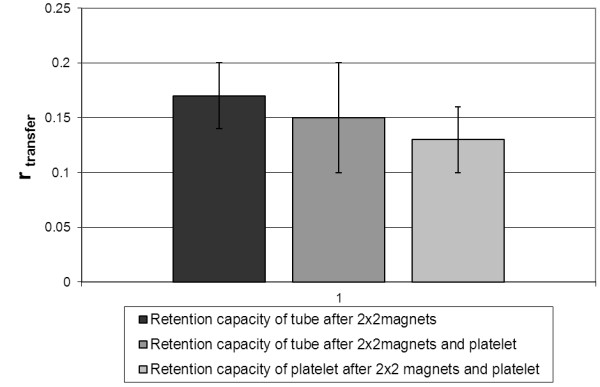
Flushing experiments simulating the in vivo situation. Retention capacity of the tube or platelet and tube, respectively, during flushing of the system with non-MNP-containing deionized water. The lowest r transfer and therefore the highest accumulation of MNPs could be found when the platelet remains in place after removal of the magnets (r transfer = 0.13 ± 0.03).